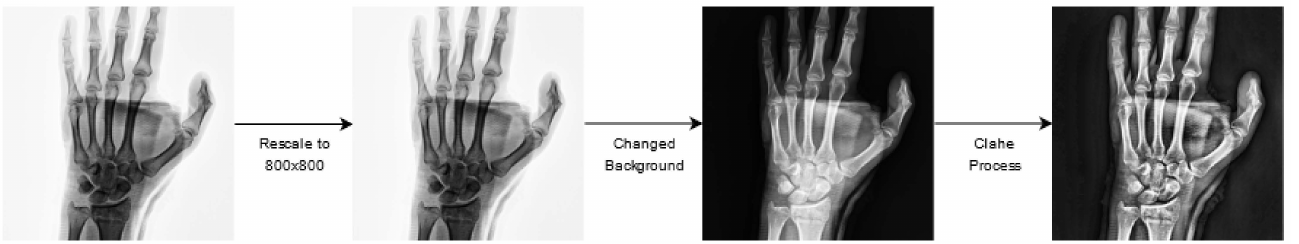
Figure 11. The wrist X-ray images after data